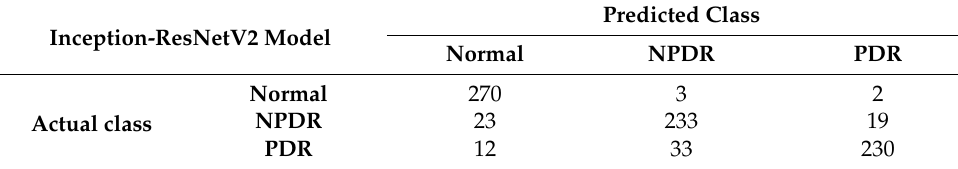
Table 5. The confusion matrix of Inception-ResNetV2.